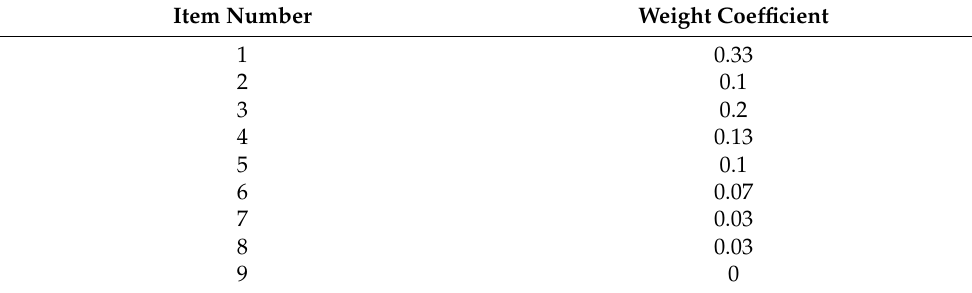
Table 5. Weight coefficient table of materials transported by freight cars.